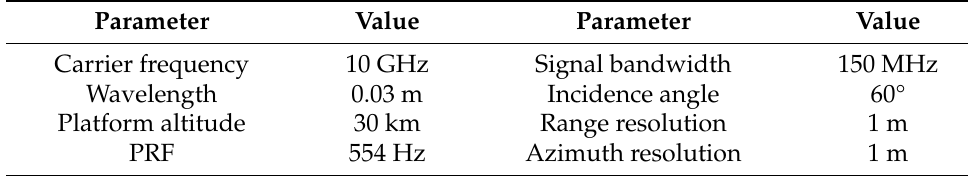
Figure 6. The spatial variations of first- and second-order RCM at θ = 50 ◦ and different platform speed. ( a ) Range walk versus flying time. ( b ) Range curvature versus flying time. Table 1. Simulation parameters for the RCM